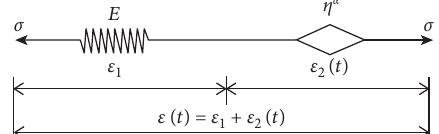
Figure 6: Fractional Maxwell rheological model